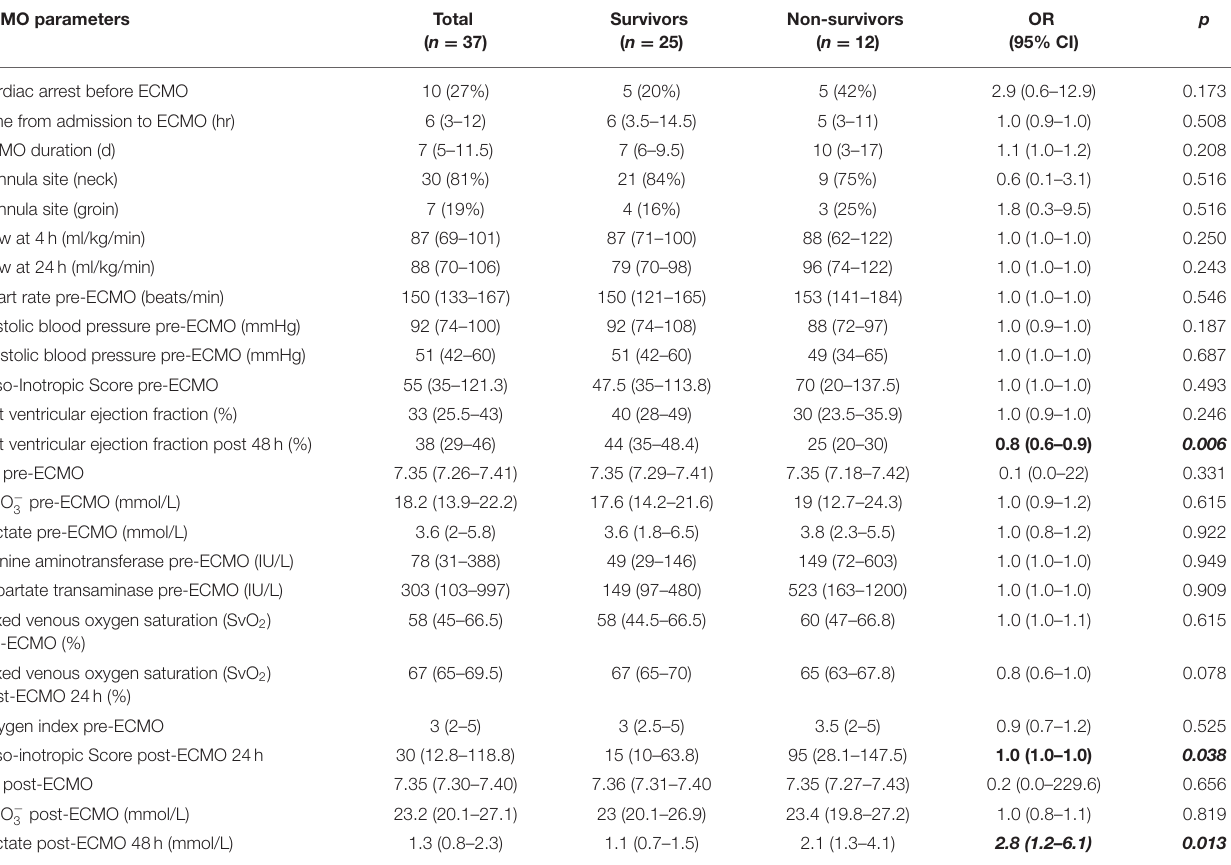
TABLE 4 | Comparison between survivors and non-survivors in terms of laboratory values before and 24h after extracorporeal membrane oxygenation. ECMO